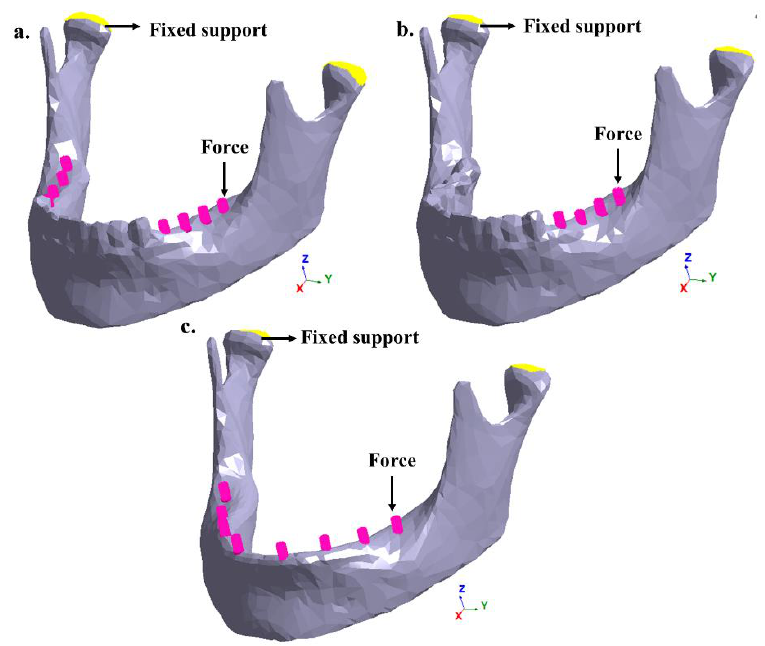
Figure 2. Boundary conditions and chewing forces: ( a ) the right and left lateral areas of the lower dental arch, ( b ) the right lateral area of the lower dental arch and ( c ) the total area of the lower dental arch.